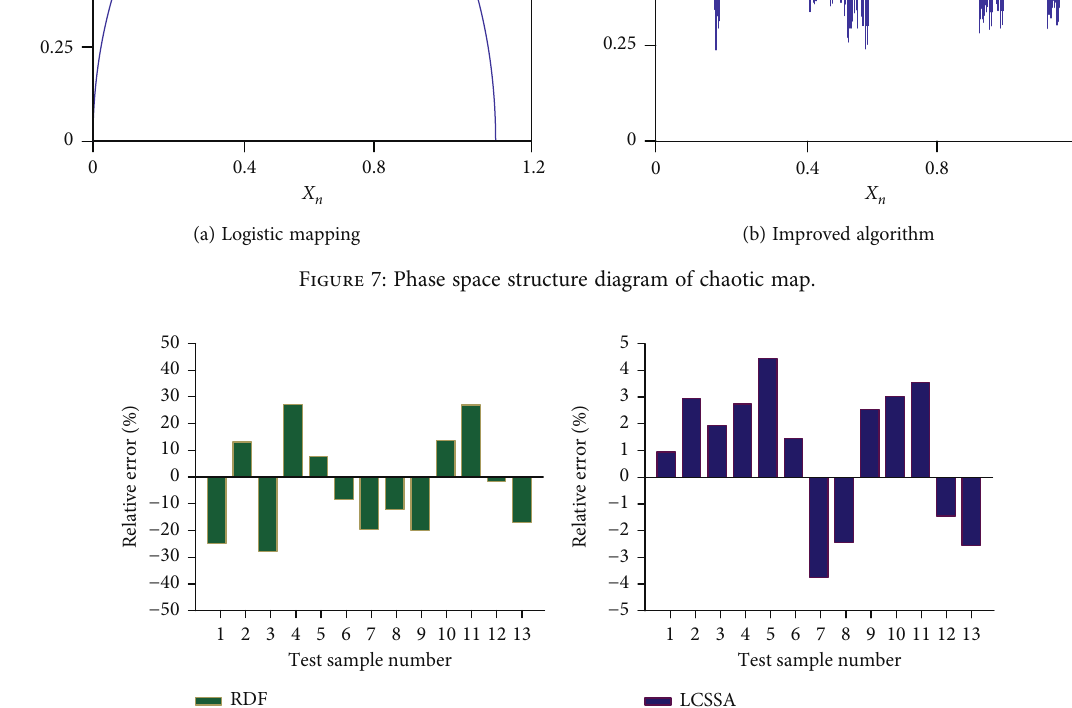
Figure 8: The average relative error of the two models.